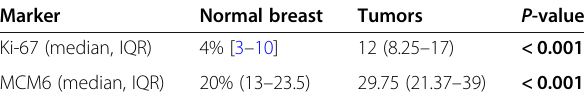
Table 2 Comparison of marker ’ s expression status (median percentage of the positive cell) in normal and tumoral samples Marker Normal breast Tumors P